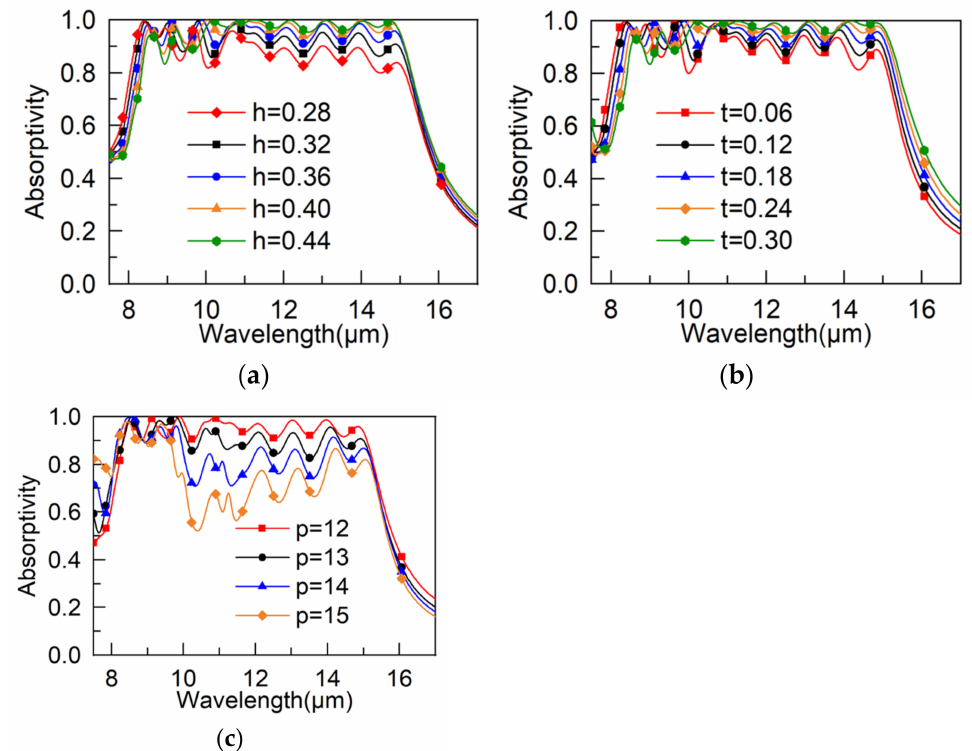
Figure 4. Absorptivity with different ( a ) thickness of dielectric layers, ( b ) thickness of gold layers, and ( c ) period geometry.